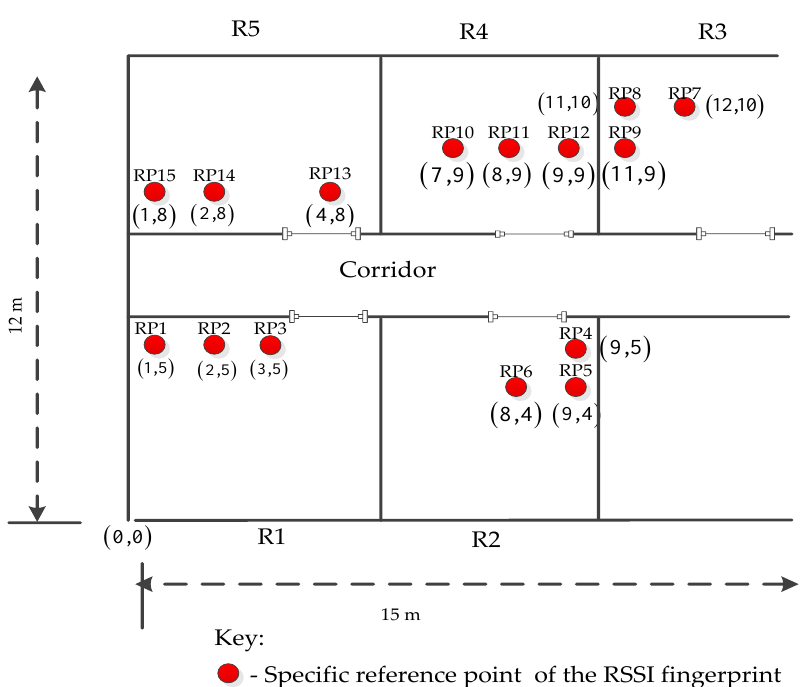
Figure 11. A location error determination system using a Cartesian coordinate